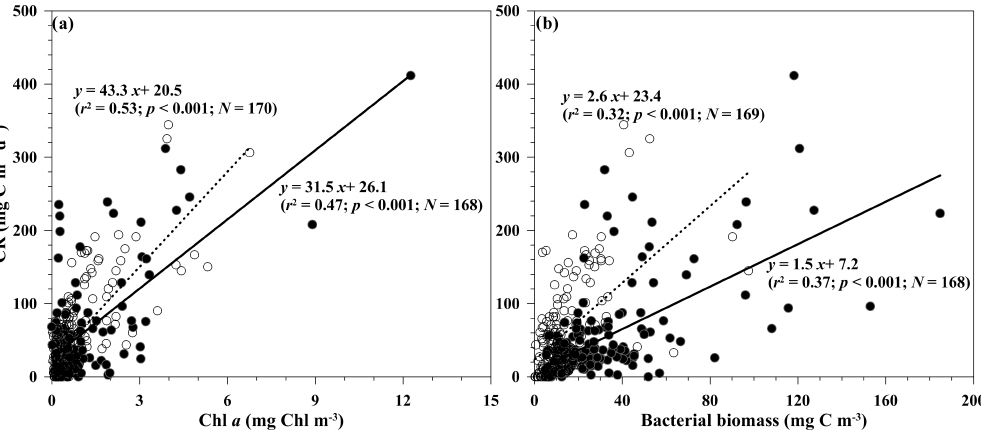
Figure 3. Relationships between plankton community respiration (CR; mgCm − 3 d − 1 ) , (a) chlorophyll a concentration (Chl a ; mgChlm − 3 ) , and (b) bacterial biomass (mgCm − 3 ) for all data from non-flooding (2009; ◦ ) and flooding (2010; • ) periods. Linear re- gressions of the data from 2009 (solid lines) and 2010 (dashed lines), as well as the respective r 2 and p values, have also been